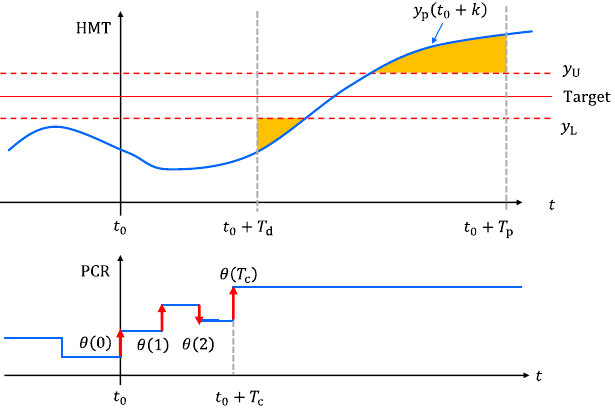
Figure 5. Decision variable and evaluation function in NMPC algorithm.